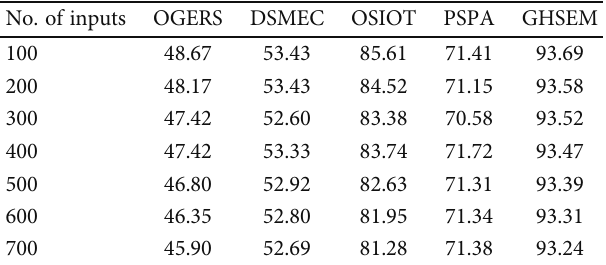
Table 3: Comparison of the design life cycle.